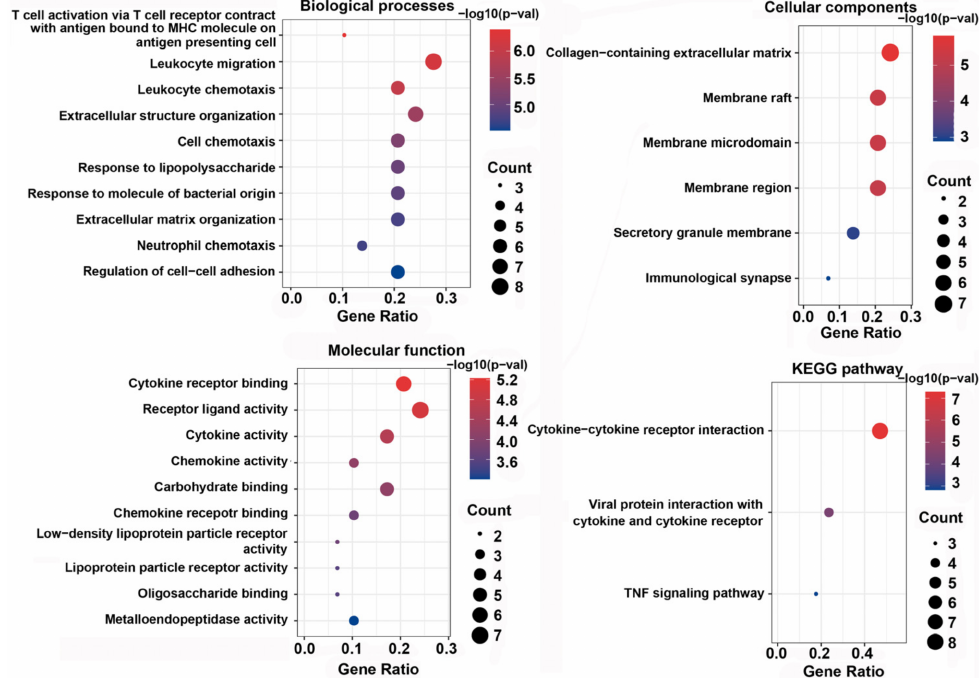
Figure 5. The most relevant biological processes (BPs), molecular functions (MFs), and cellular com- ponents (CCs) through GO enrichment analysis, and KEGG pathway enrichment analysis of differen- tially expressed proteins between EVs isolated from the Icariin-treated group and the Model